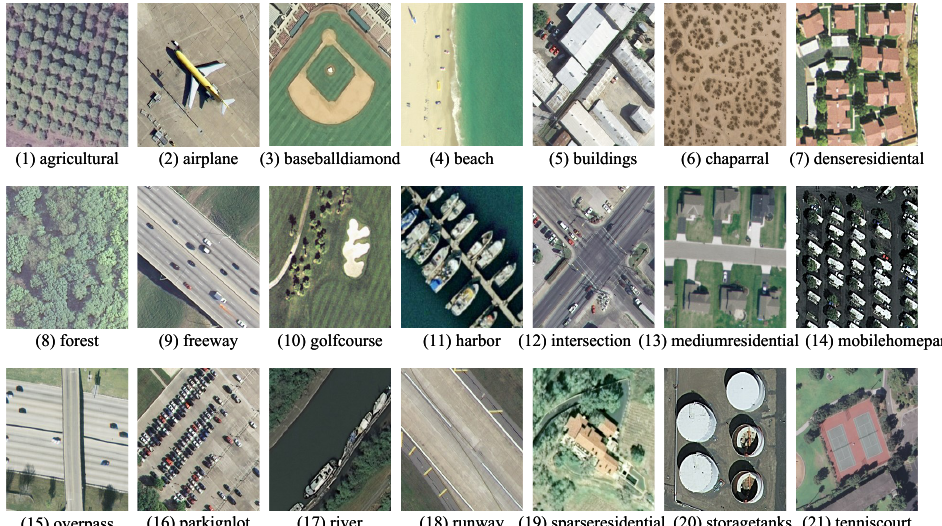
Figure 4. Sample images of the UC Merced Land Use Database